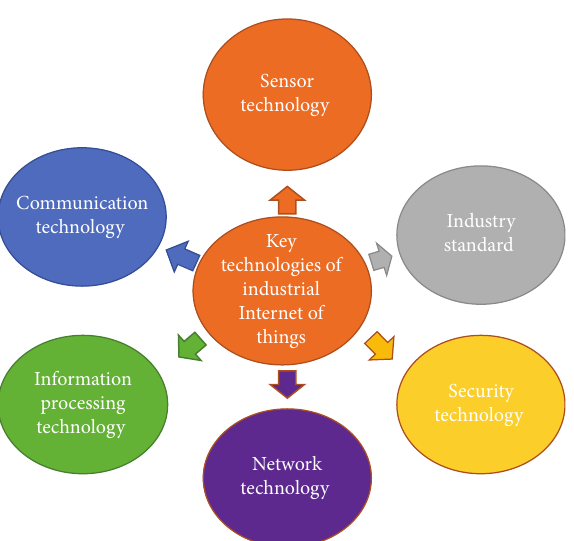
Figure 4: Key technologies of industrial